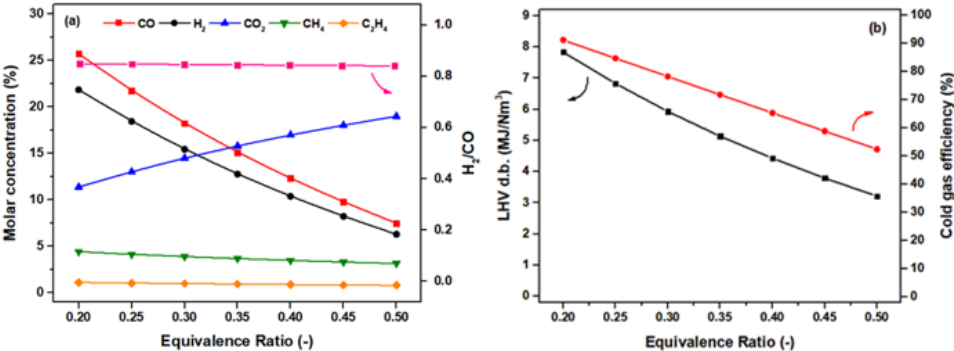
Figure 11. Effect of equivalence ratio on syngas composition ( a ) and on LHV (dry basis) and cold gas efficiency ( b ). Reaction temperature = 834 °C.